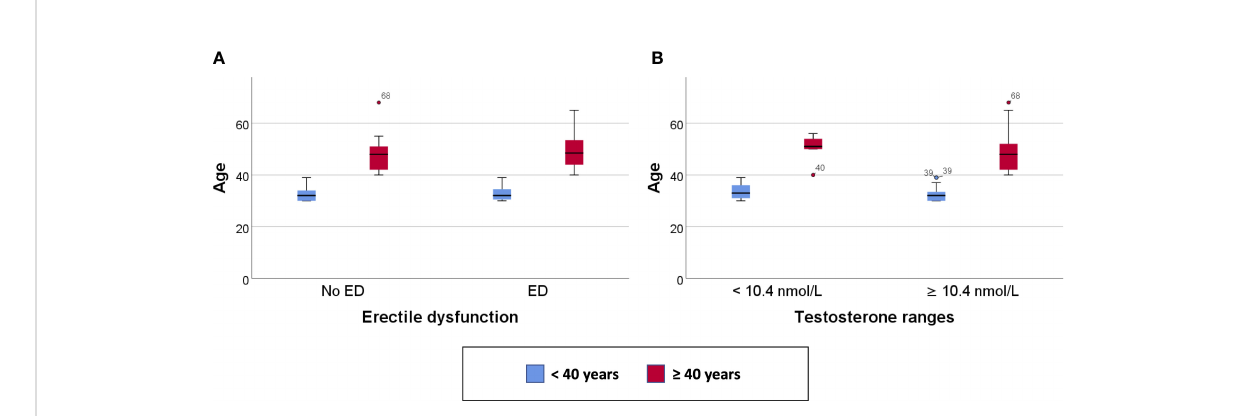
FIGURE 1 Clustered Box plot for: Age by sexual function (A) and serum testosterone level (B) in participants < or ≥ 40 years of